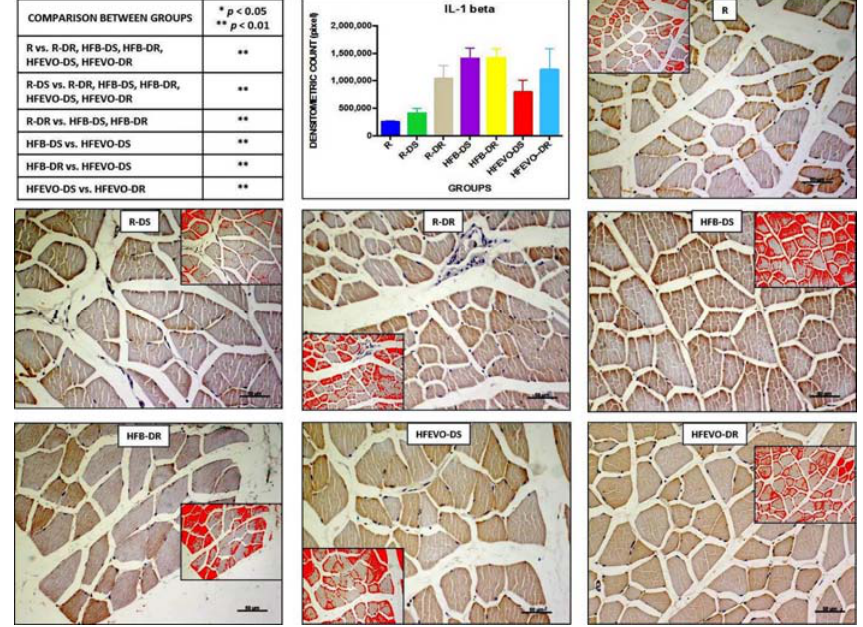
Figure 3. IL ‐ 1 β immunostaining, image analysis by software in which the red color represents the immunolabelling (inserts), and a graph representing the immunostained area % with statistical analysis ( p ‐ values in the table). For details, see the text. The data are presented as mean ± SD. Scale bars: 50 μ m.